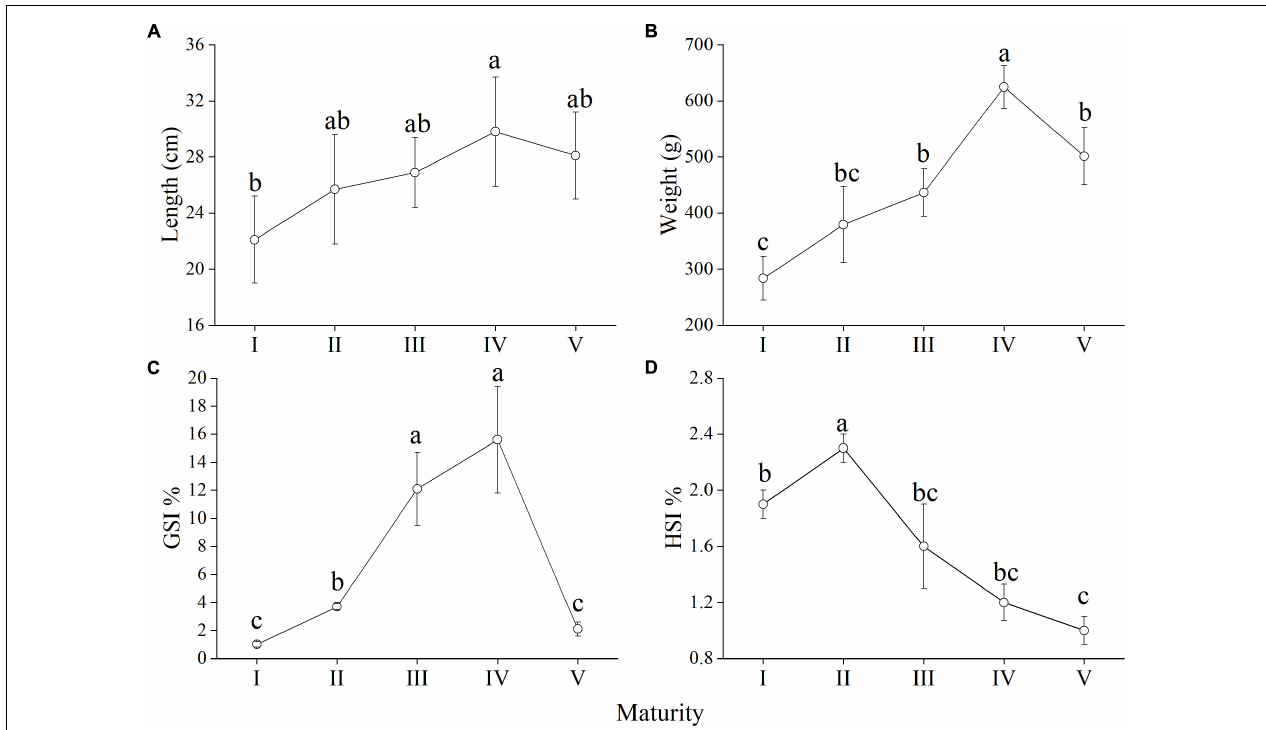
FIGURE 3 | Line chart showing the distribution of (A) body length, (B) body length data across Megalobrama terminalis maturity stages. Shown are also the patterns in (C) gonadosomatic index (GSI), and (D) hepatosomatic index (HSI) of M. terminalis . Different superscript letters indicate significant differences of component in different maturity stage, p < 0.05.